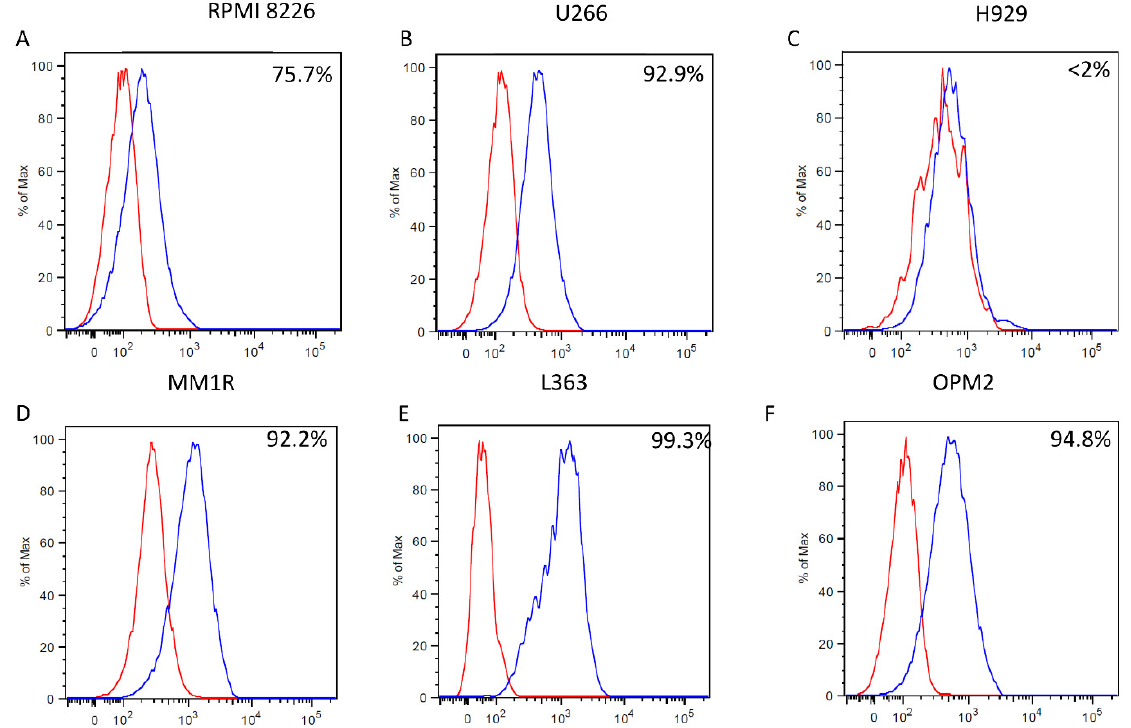
Figure 1. Expression level of cell surface PCNA on different multiple myeloma cell lines. The six different multiple myeloma cell lines indicated ( A – F ) were stained with anti-membranal PCNA antibody mAb 14-25-9 (blue line) and mIgG1 control antibody (red line). The cell-bound signal was measured by flow cytometry and analyzed using FlowJo v10. Data are presented from three independent biological replicates and at least two independent experiments. Percentages indicate the fraction of cells positive for membranal PCNA.